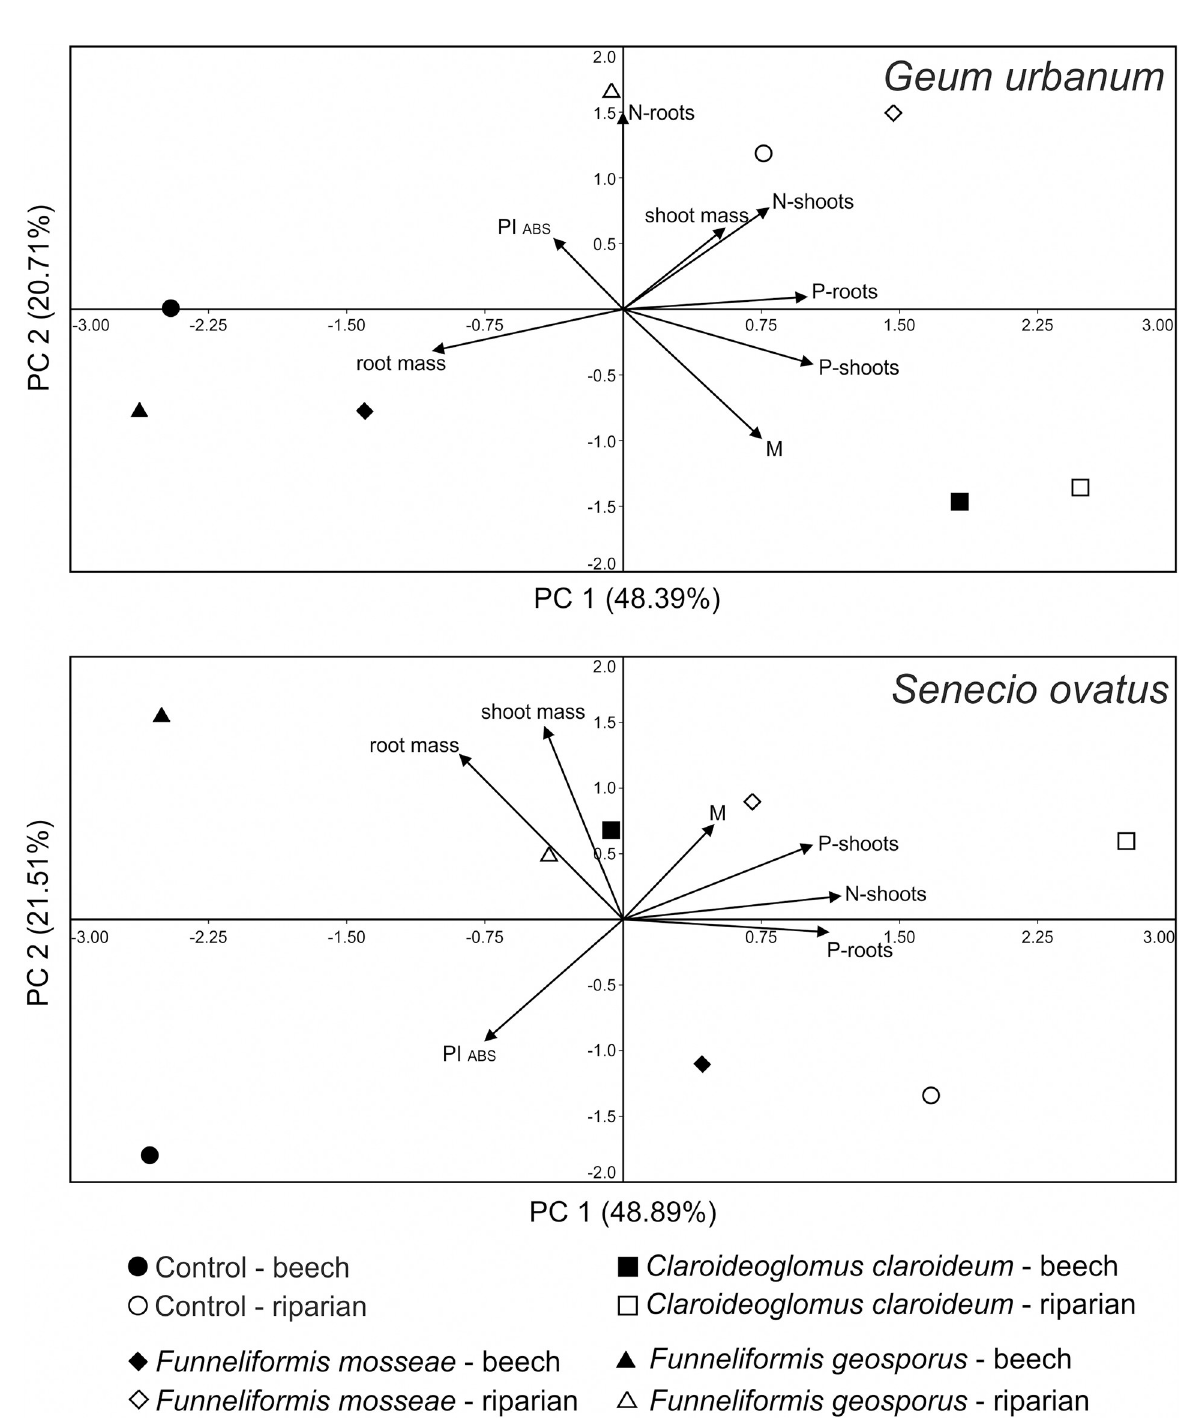
Fig 5. Principal component analysis ordination diagram (PC 1 vs PC 2) of Geum urbanum and Senecio ovatus parameters (M—relative mycorrhizal root length, shoot and root mass, N and P contents in shoots and roots, PI ABS ) for samples of the two soil types and four fungal treatments. The percentage of total variance, as explained by each axis, is